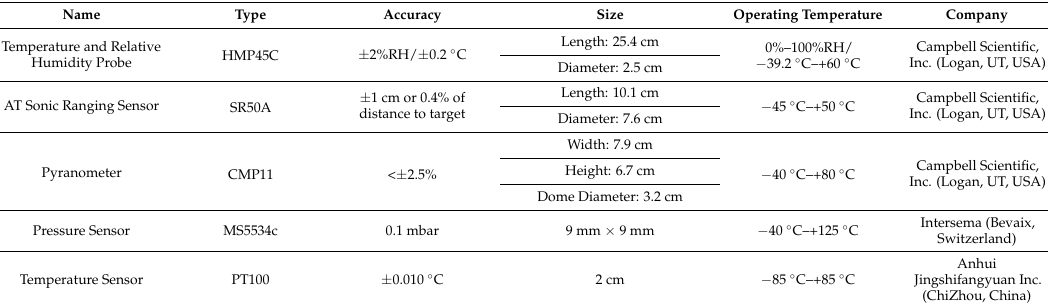
Table 1. Sensor characteristics in the meteorological/snow instrument.